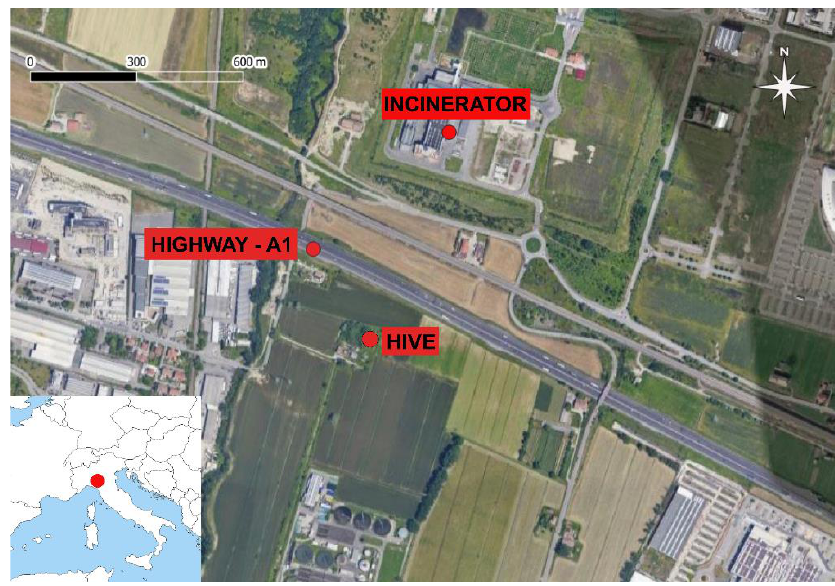
Figure 1. Area of investigation. Red dots represent the location of the hive with respect to the A1 highway and the incinerator plant [24].